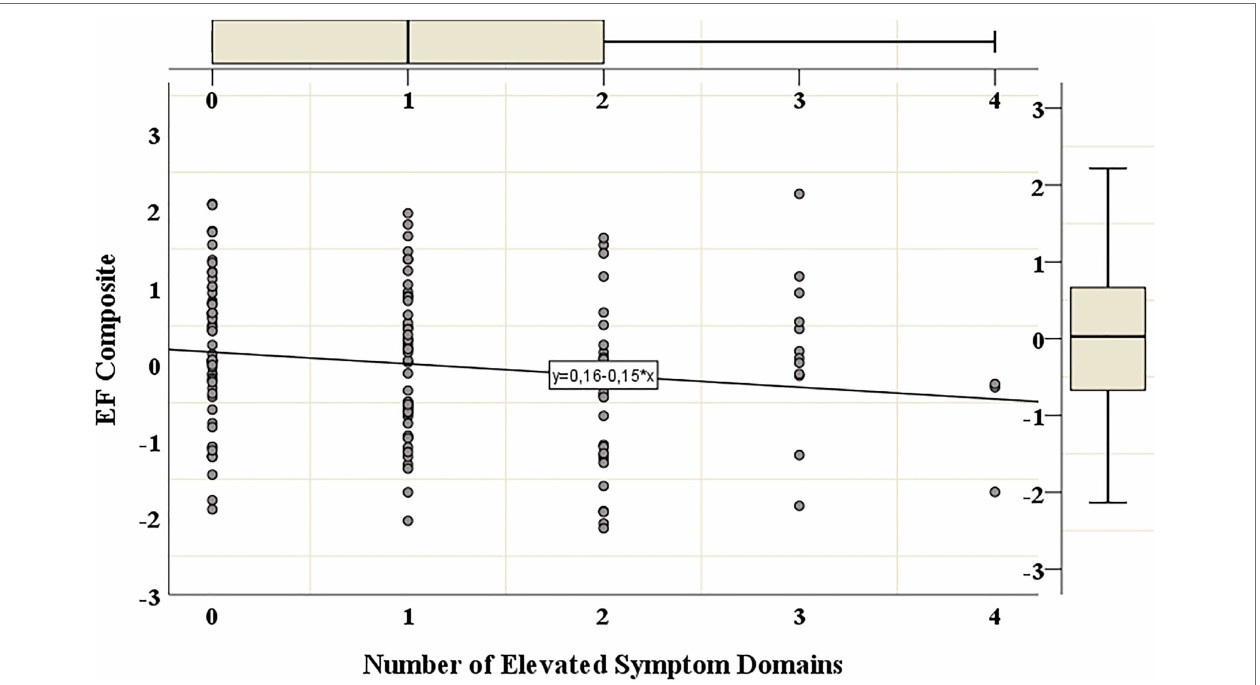
FIGURE 1 | Executive functioning grouped according to number of elevated symptom domains. The scatterplot with a fitted regression line shows the distribution of the participants’ EF levels, as grouped according to the number of domains (i.e., depression, anxiety, insomnia, and poor couple relationship adjustment) with clinically elevated symptom levels. EFs were measured with a composite score based on five Cogstate tasks, a higher value indicates better EFs. The EF composite’s mean was set to zero through standardization. The values on the vertical axis refer to standard deviations from the EF mean value. Psychological distress was measured with self-report questionnaires (the Edinburgh Postnatal Depression Scale, the Anxiety Subscale from The Symptom Checklist-90, the Athens Insomnia Scale, and the Revised Dyadic Adjustment Scale). The number of elevated symptom domains refers to the number of concurrent psychological distress domains which cross-cutoff values for clinically elevated symptom